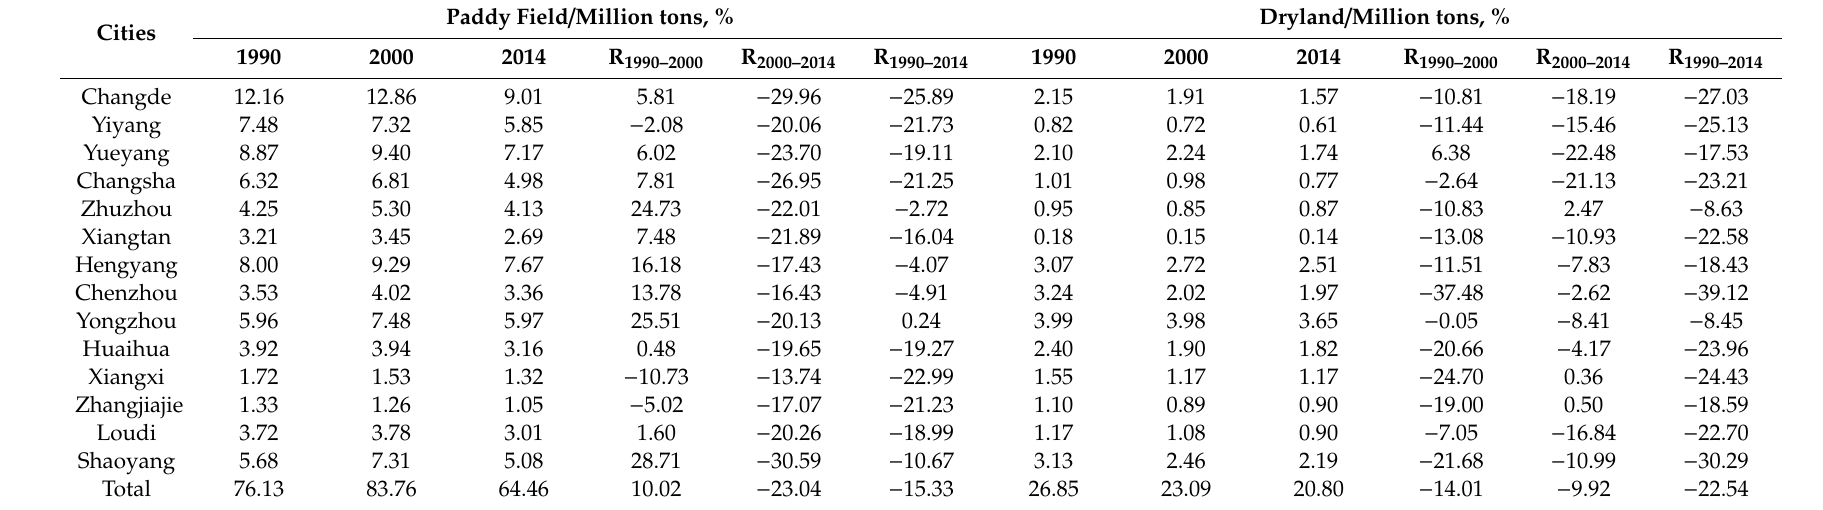
Table 2. The change in potential grain production in Hunan Province from 1990 to 2014.